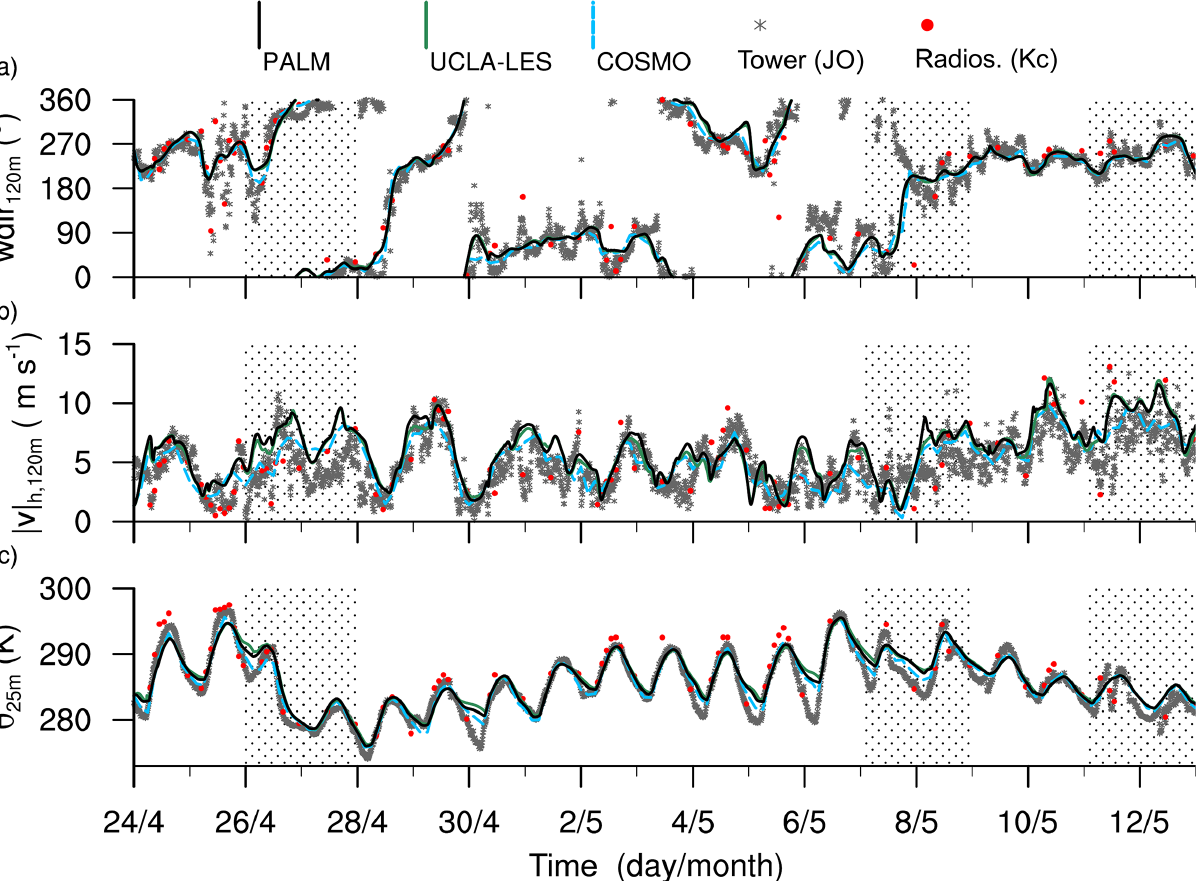
Figure 7. Temporal evolution of wind direction at 120m height wdir 120m in (a) , wind speed at 120m height | v | h , 120m in (b) and potential temperature at 25m height θ 25m in (c) . An overview of the measurements and abbreviations is given in Table 1. Stippled highlighting as in Fig.